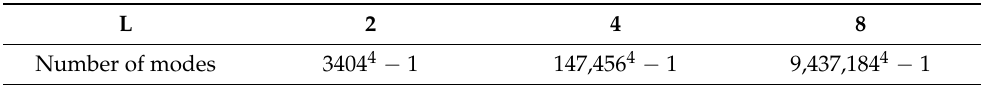
Table 2. Analysis of functional modes.